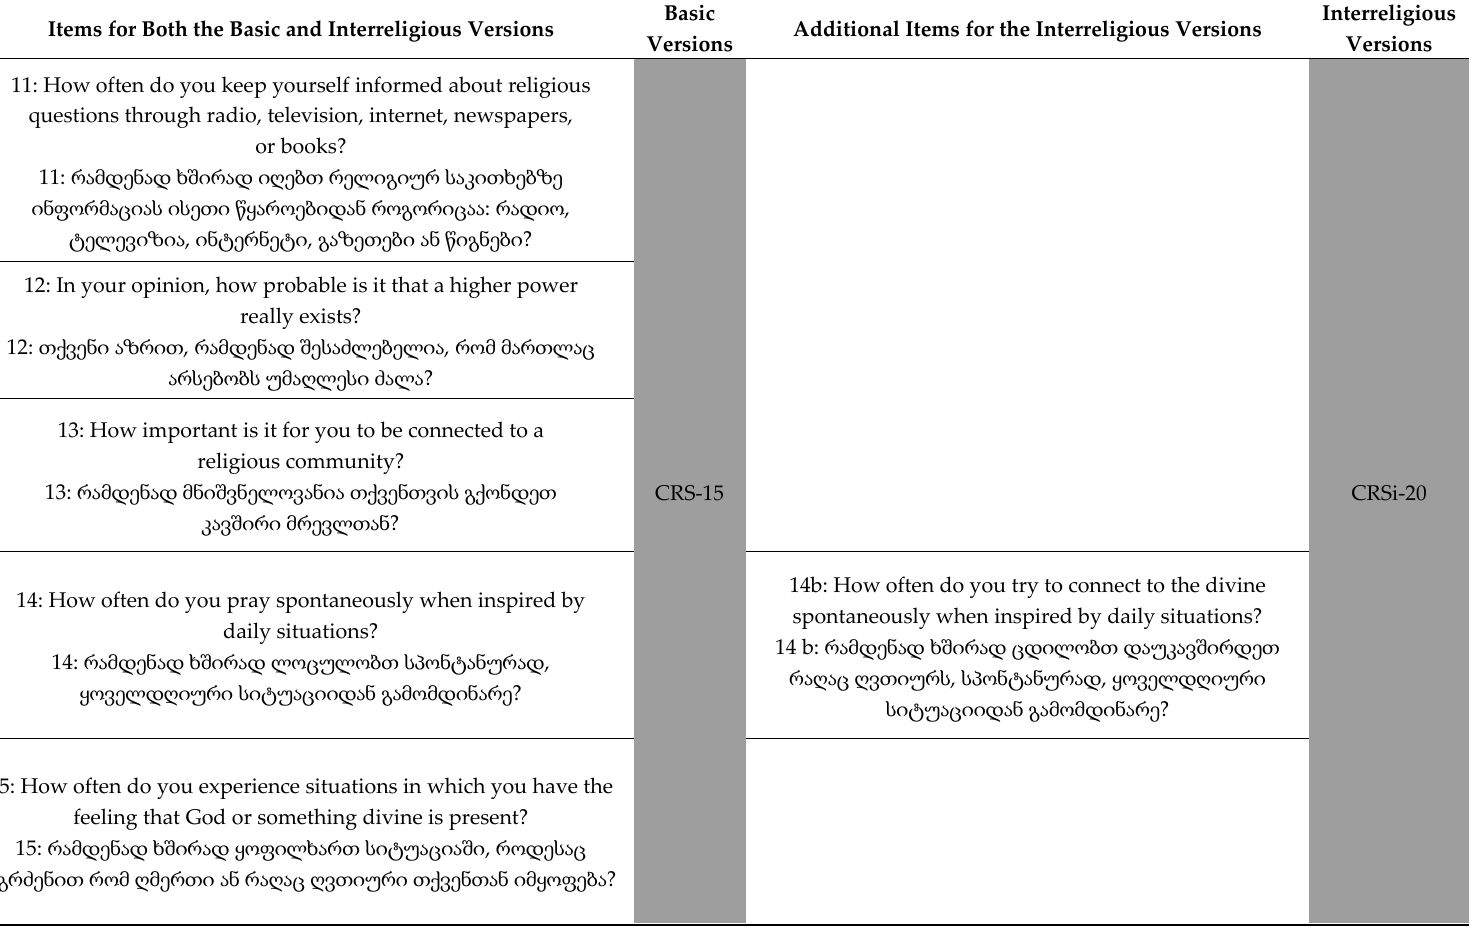
Table A3. Items of the CRS shared by the long versions.